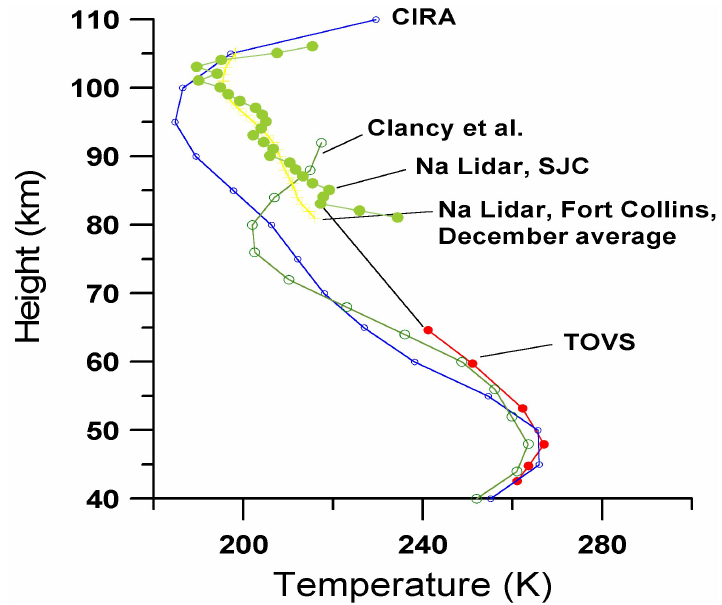
Fig. 2. Comparison between mean temperature profile for 23 ◦ S (SJC) and other profiles (after Clemesha et al., 1999).